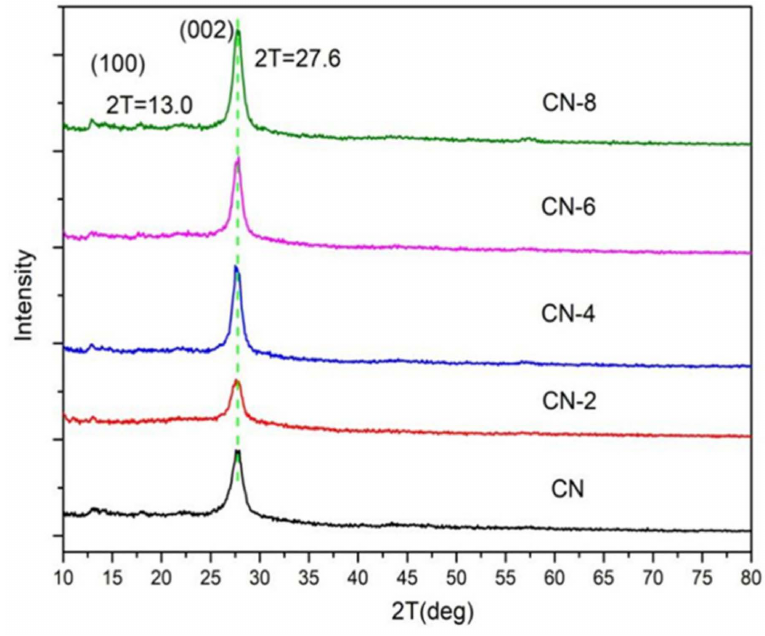
Figure 2. XRD patterns of the